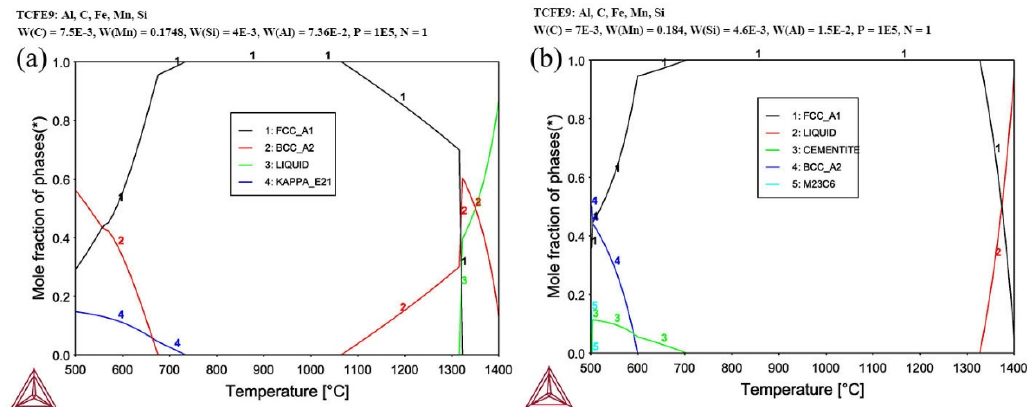
Figure 7. Relationship between equilibrium phases and temperature in steels: ( a ) steel 1# and ( b ) steel 2#. FCC_A1: austenite. BCC_A2: δ -ferrite. LIQUID: cementite. KAPPA_E21: κ carbide.M23C6: M 23 C 6 carbide. According to thermodynamic analysis, the δ -ferrite phase would remain in the microstructure after hot rolling for steel 1#. Therefore, it could be found at the temperature of 650 °C after solid solution treatment for 6 min, as shown in Figure 8.